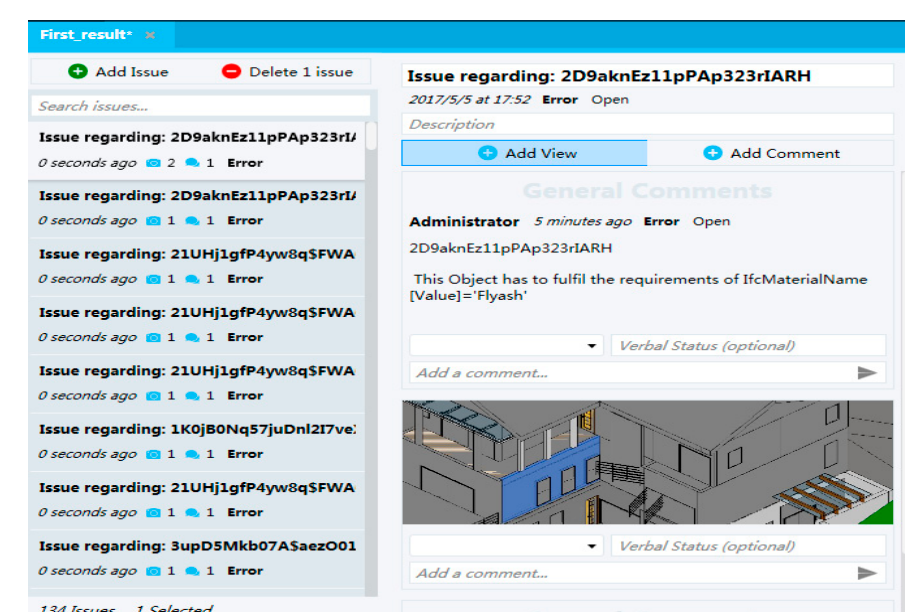
Figure 16. The BCF report of the code checking.